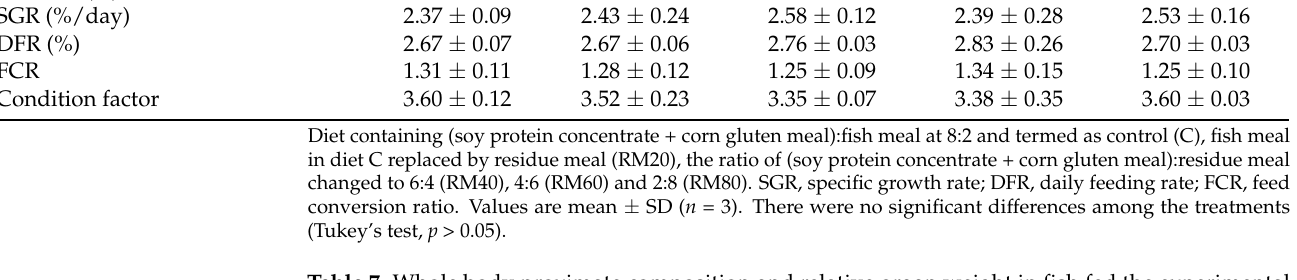
Table 7. Whole body proximate composition and relative organ weight in fish fed the experimental diets in Trial 1.